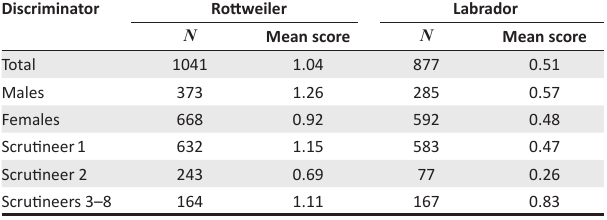
TABLE 2b: Elbow dysplasia grading score in Rottweilers and Labrador retrievers as well as in males versus females and primary versus secondary versus remaining scrutineers for both elbows (0–3 per elbow).